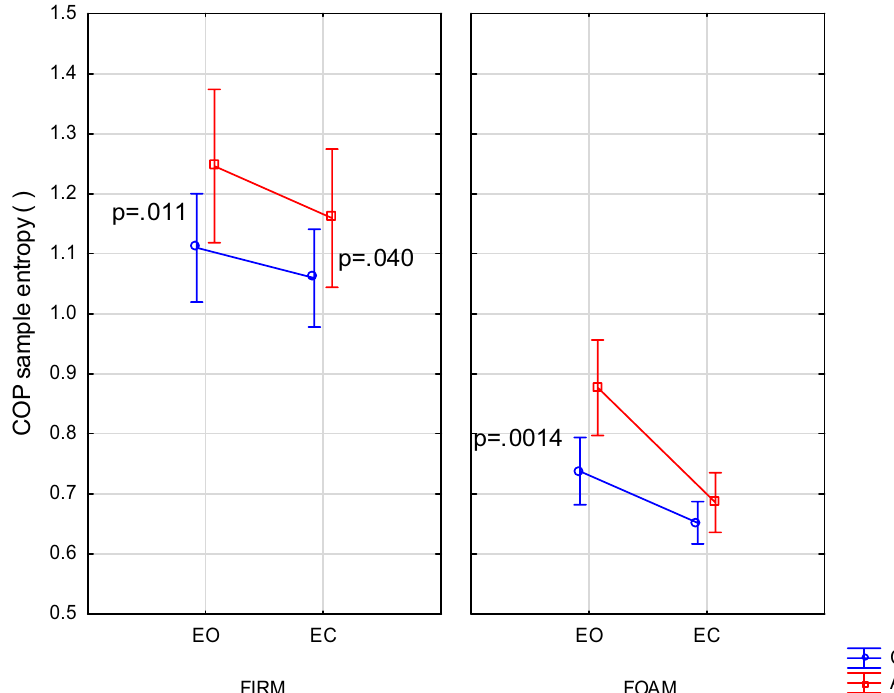
Figure 3. COP sample entropy comparison between girls with scoliosis (AIS) and controls (CON) in trials with eyes open (EO) or closed (EC) on firm or foam